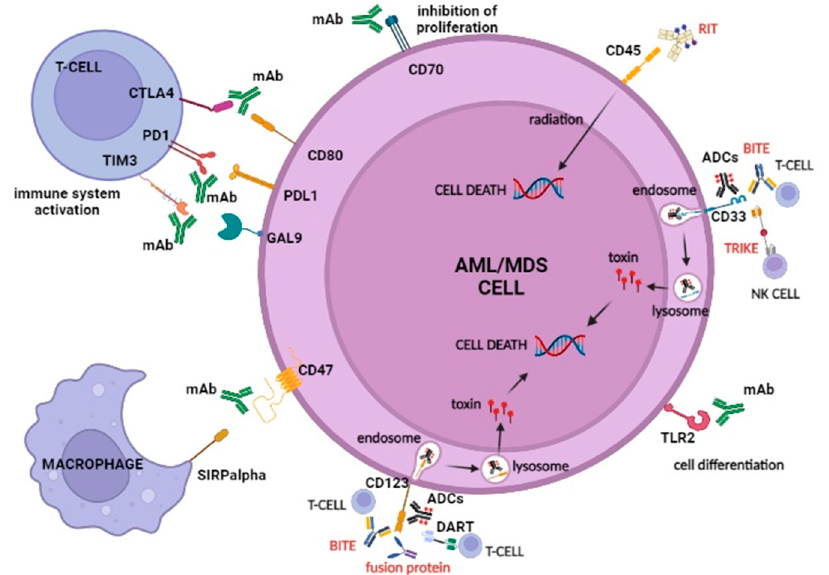
Figure 1. Main targets and modes of action of immunotherapy in AML/MDS. Monoclonal antibodies (mAb), radioimmunotherapy (RIT), antibody-drug conjugates (ADC), bispecific T-cell engagers (BiTE), trispecific killer engagers (TriKE), fusion protein, dual affinity retargeting antibodies (DARTs), and their targets in AML/MDS are represented. Emerging mAbs for AML and MDS are directed against the macrophage mediated phagocytosis inhibitor CD47, immune checkpoint molecules (CTLA4, PD-1/PD-L1, and TIM3), and TLR2. BiTEs lead to a physical interaction between T-cells and leukemic cells. TriKE, consisting of a fusion of two scFv, one against CD33 and one against CD16, bridged by an IL15 linker that promotes NK activation, inducing a cytolytic response by targeting CD33 and CD123 on leukemic cells. DARTs are composed of a diabody backbone with a c-terminal disulfide bridge that improves stabilization and causes stronger B cell lysis and T cell activation in comparison with other types of bi-specific mAbs. ADCs, RIT, and fusion proteins, by binding to their targets, deliver the conjugated compound, which fulfills its toxic action on the tumor cells. Image created with BioRender.com (accessed on 6 June 2022).